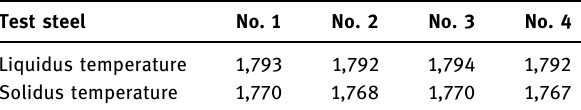
Table 2: Liquidus temperature and solidus temperature of test steels with and without addition of yttrium ( K ) Test